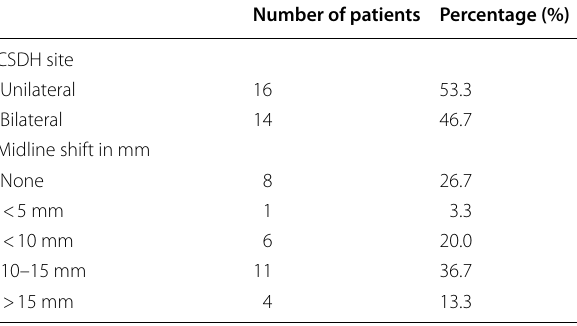
Table 3 Preoperative CSDH laterality and degree of midline